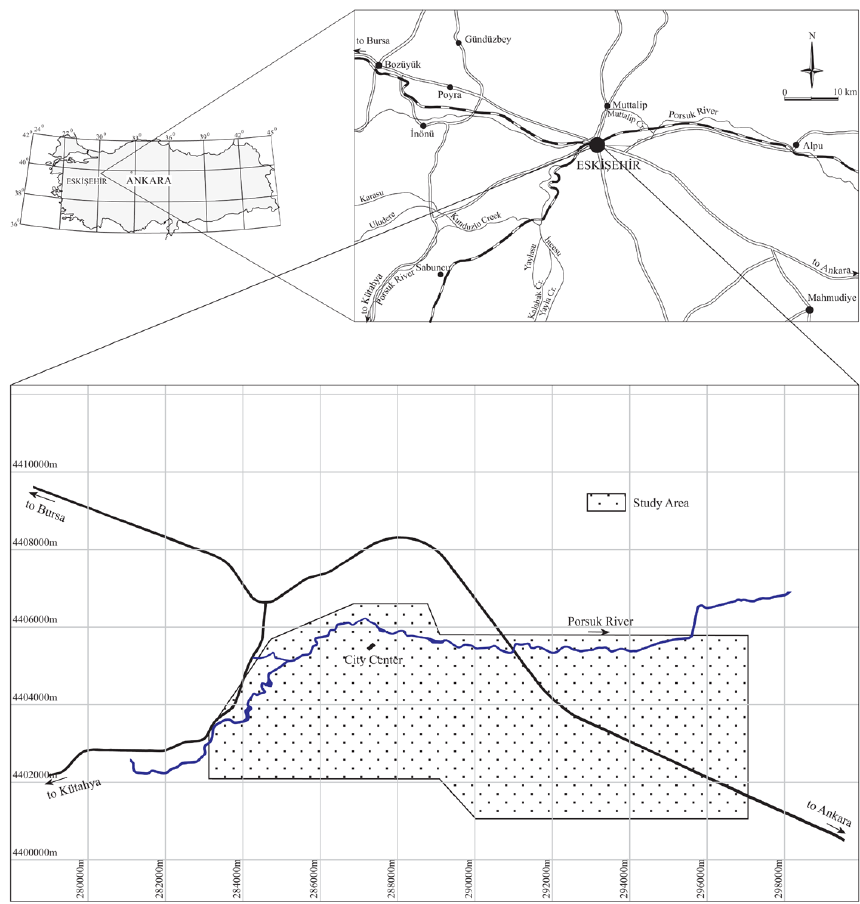
Fig. 1. Location map of the study